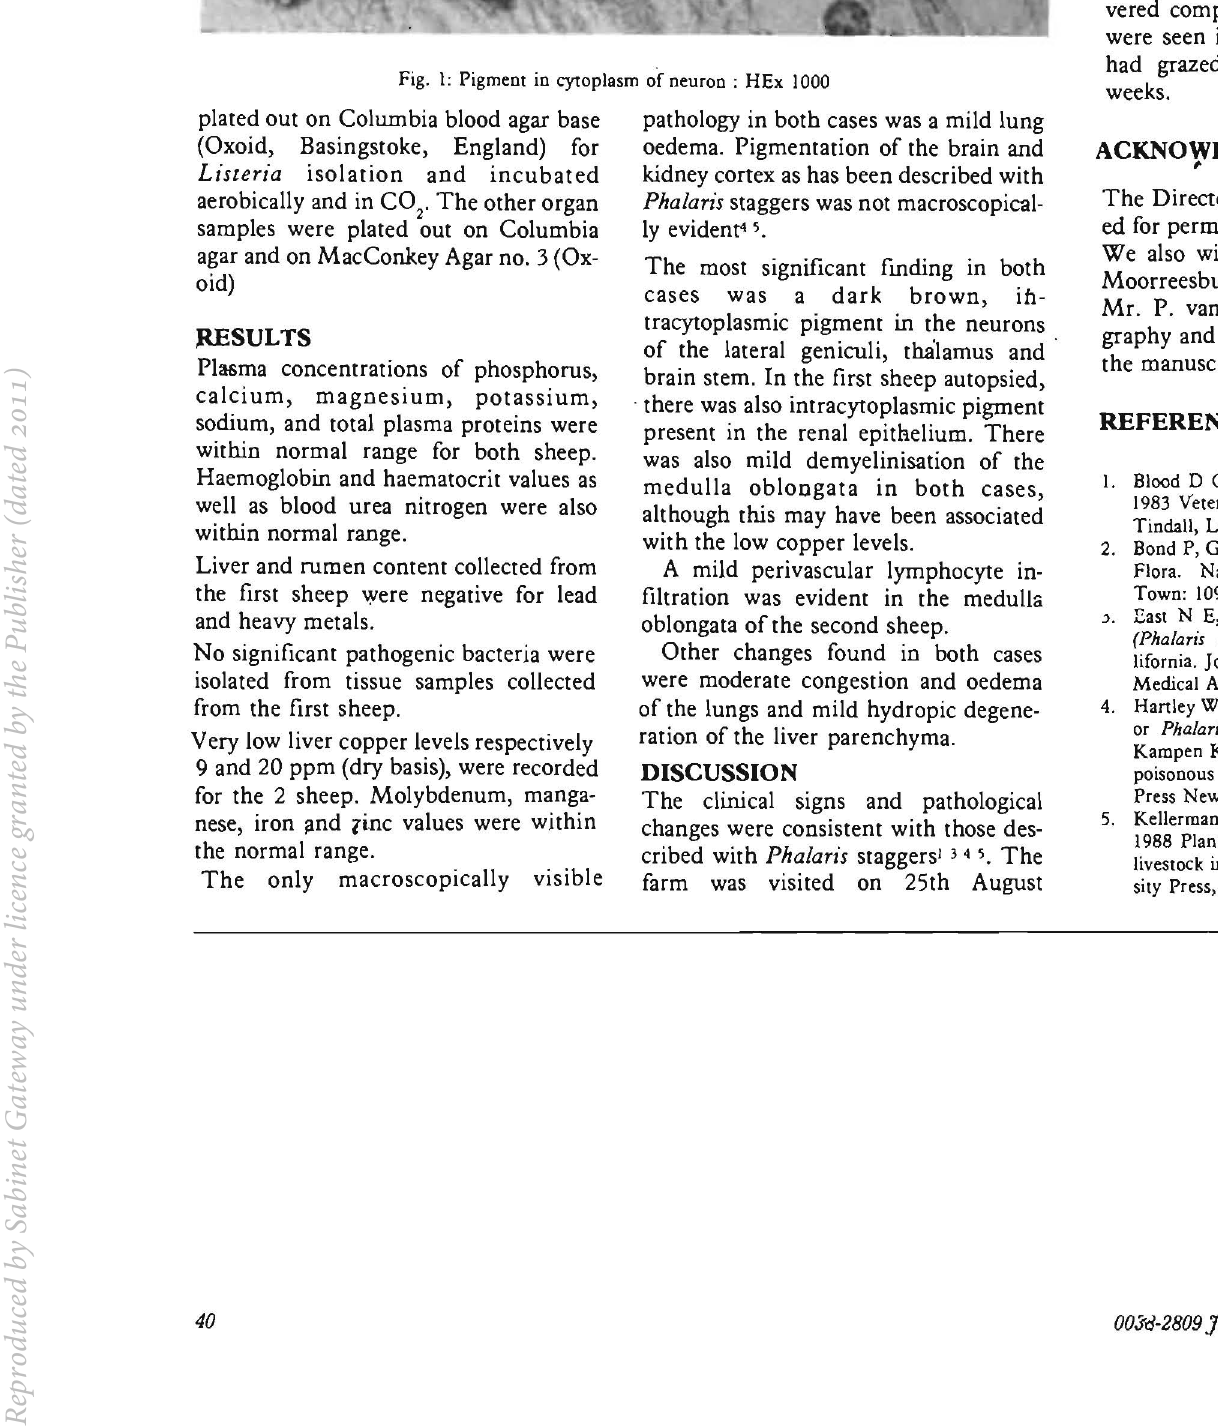
Fig. I: Pigment in cytoplasm of neuron: HEx